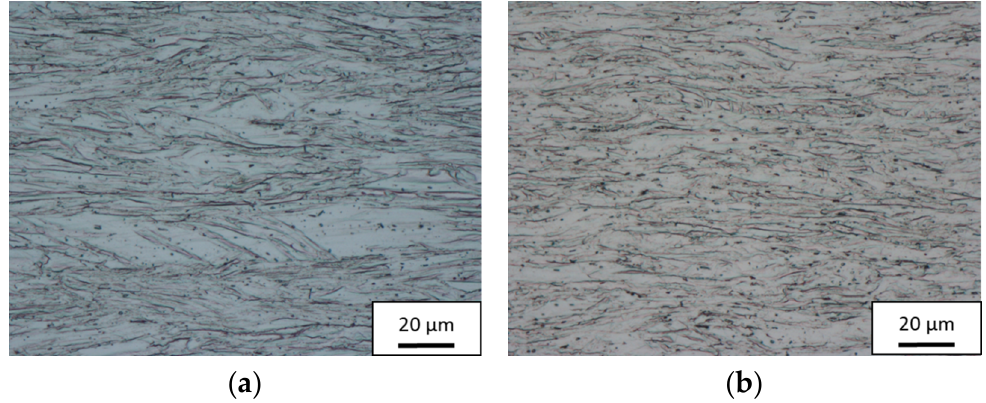
Figure 12. Optical micrographs after rotary swaging (1.6. true strain—80% area reduction): longitudinal cross-section ( a ) for titanium Grade 2, ( b ) for titanium Grade 4.